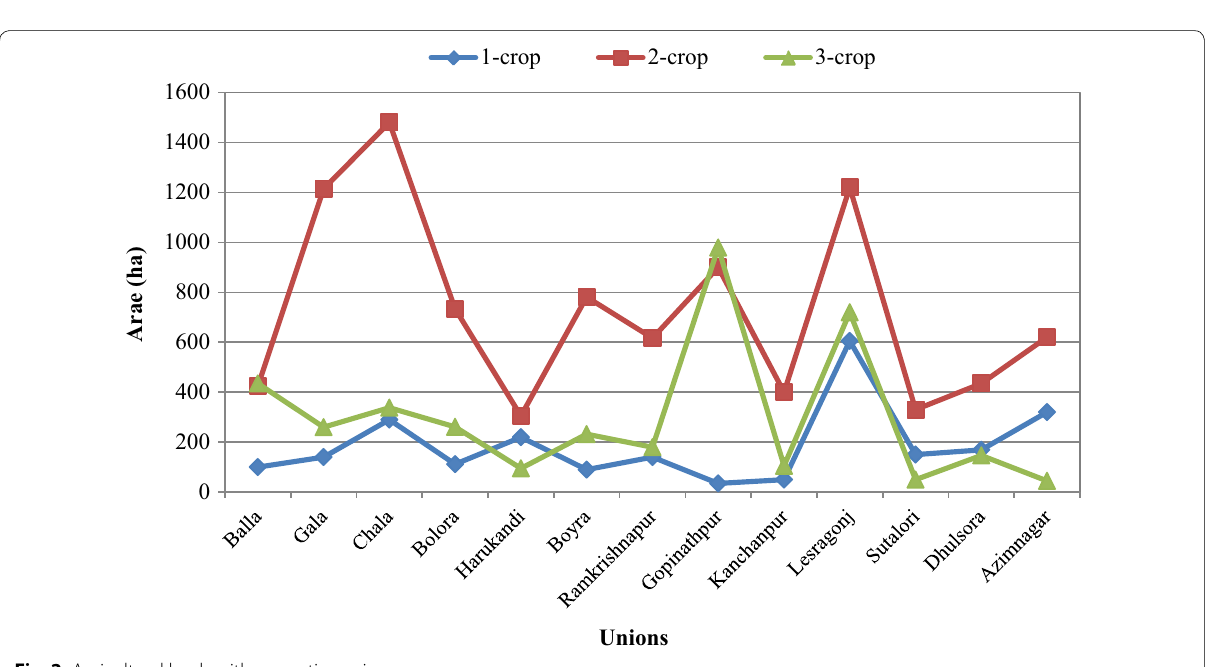
Fig. 2 Agricultural lands with respective